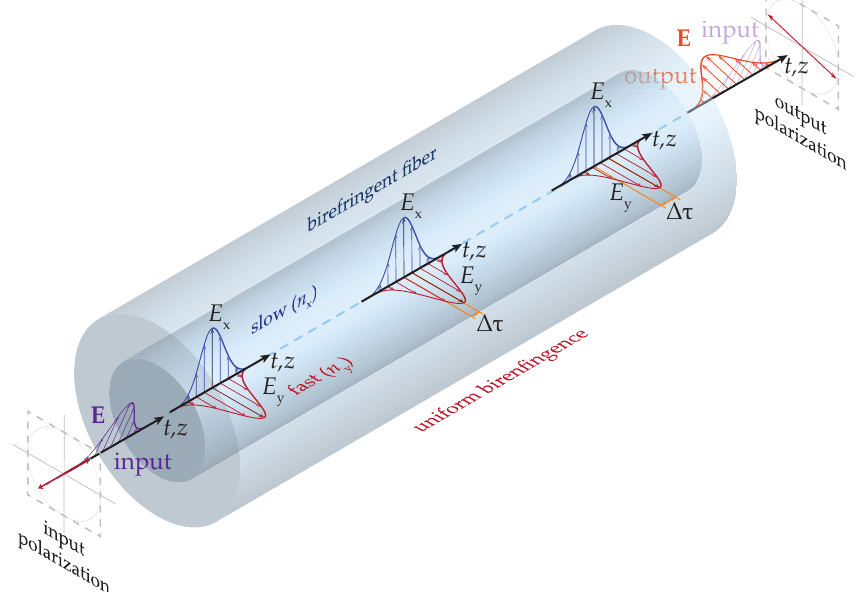
Figure 1. Schematics of the uniform birefringence and its influence on the polarization state of orthogonal modes propagating along the optical